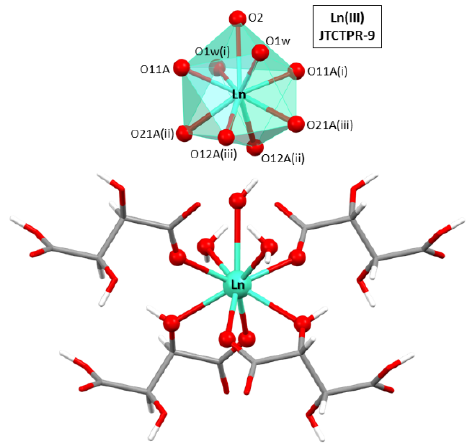
Figure 1. Excerpt of the crystal structure of compound 2D_Gd-L showing the coordination polyhe- dron for Ln(III) atoms. Symmetries: (i) − 1 + y, 1 + x, 1 − z; (ii) − 1 + x, y, z; and (iii) − 1 + y, x, 1 − z.